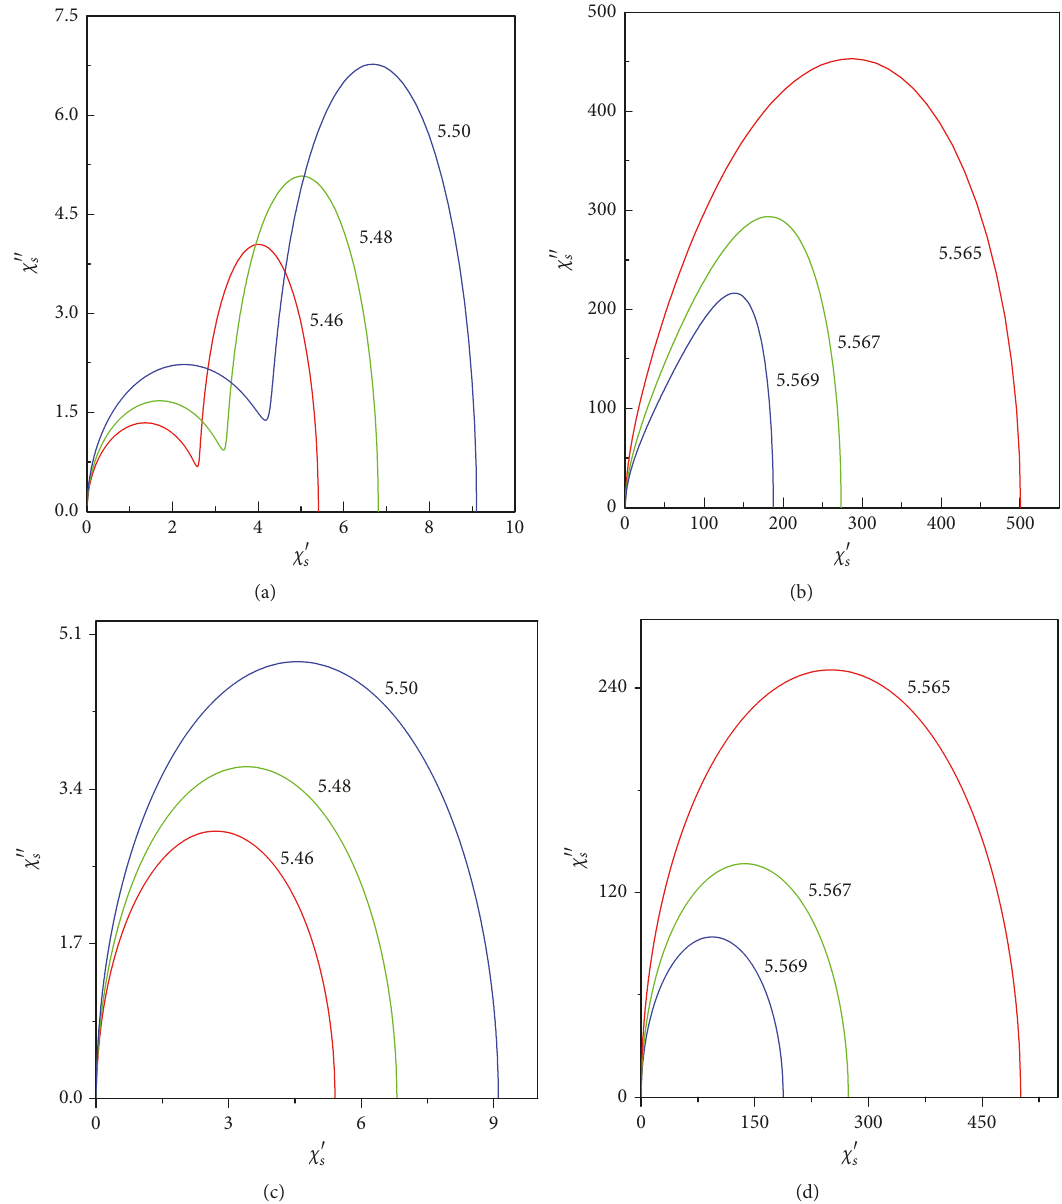
Figure 4: Cole-Cole plots of 𝜒 𝑠 (𝜔) in the (a) metamagnetic phase and (b) paramagnetic phase while 𝛾 𝑠 = −10.0 , 𝛾 𝑚 = −0.01 , and 𝛾 = −0.001 . Cole-Cole plots of 𝜒 𝑠 (𝜔) in the (c) metamagnetic phase and (b) paramagnetic phase for 𝛾 𝑠 = −10.0 , 𝛾 𝑚 = −9.0 , and 𝛾 = −0.001 . The number accompanying each curve is the value of the reduced temperature and 𝑟 = 1.0 , 𝐻 𝑟